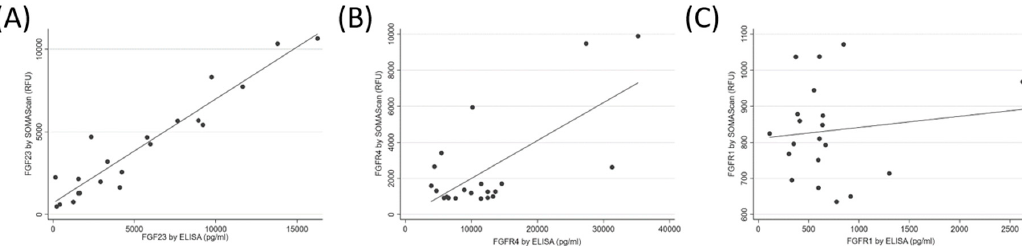
Figure 2. Correlation between SOMAscan and Enzyme-Linked immunosorbent assay (ELISA) measurements of fibroblast growth factor 23 (FGF23, panel ( A )), fibroblast growth factor receptor 4 (FGFR4, panel ( B )), and fibroblast growth factor receptor 1 (FGFR1, panel ( C )) in human plasma.